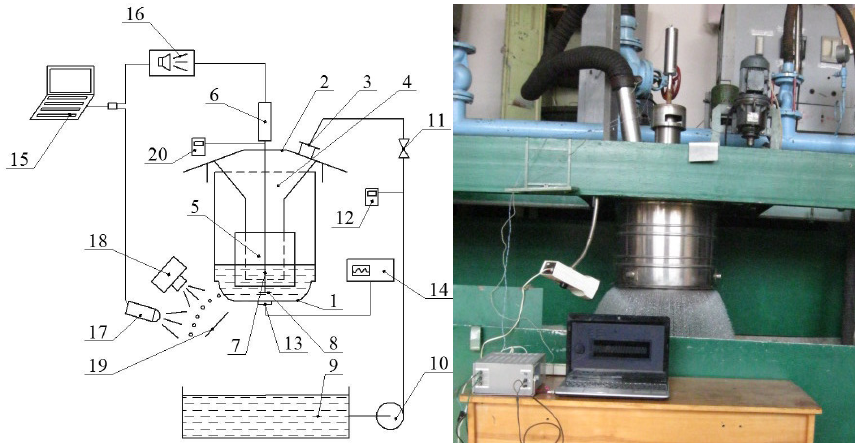
Figure 1. Experimental setup of the vibratory granulator: 1—perforated bottom; 2—housing;